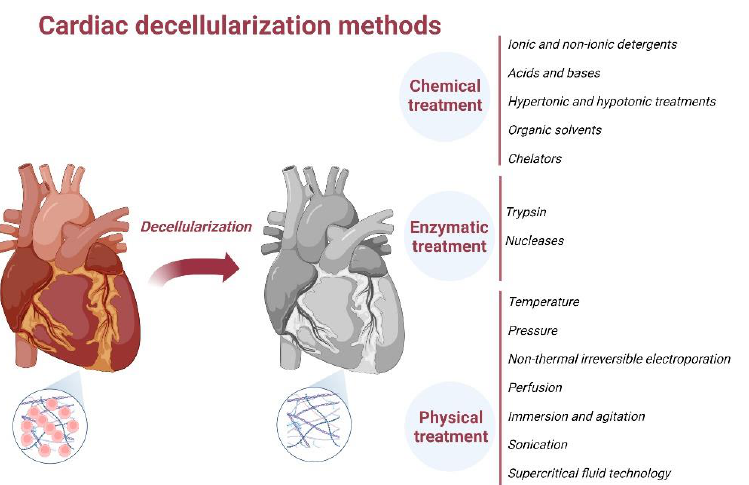
Figure 3. Cardiac decellularization. The decellularization removes all cellular components, creating a stable, biologically active scaffold. Different decellularization methods were used over time, including chemical, enzymatic, physical or combination. Created with BioRender.com.